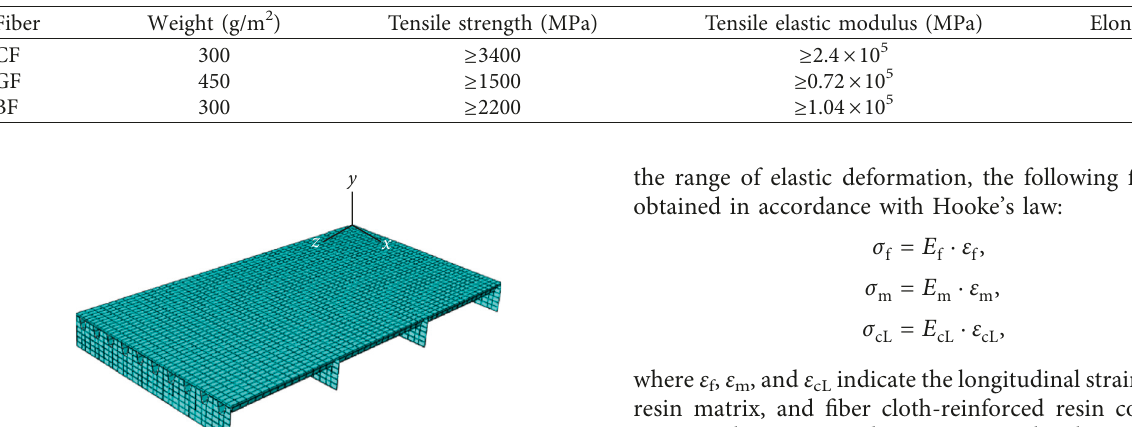
Table 3: Requirements of technical indexes of fiber cloth.